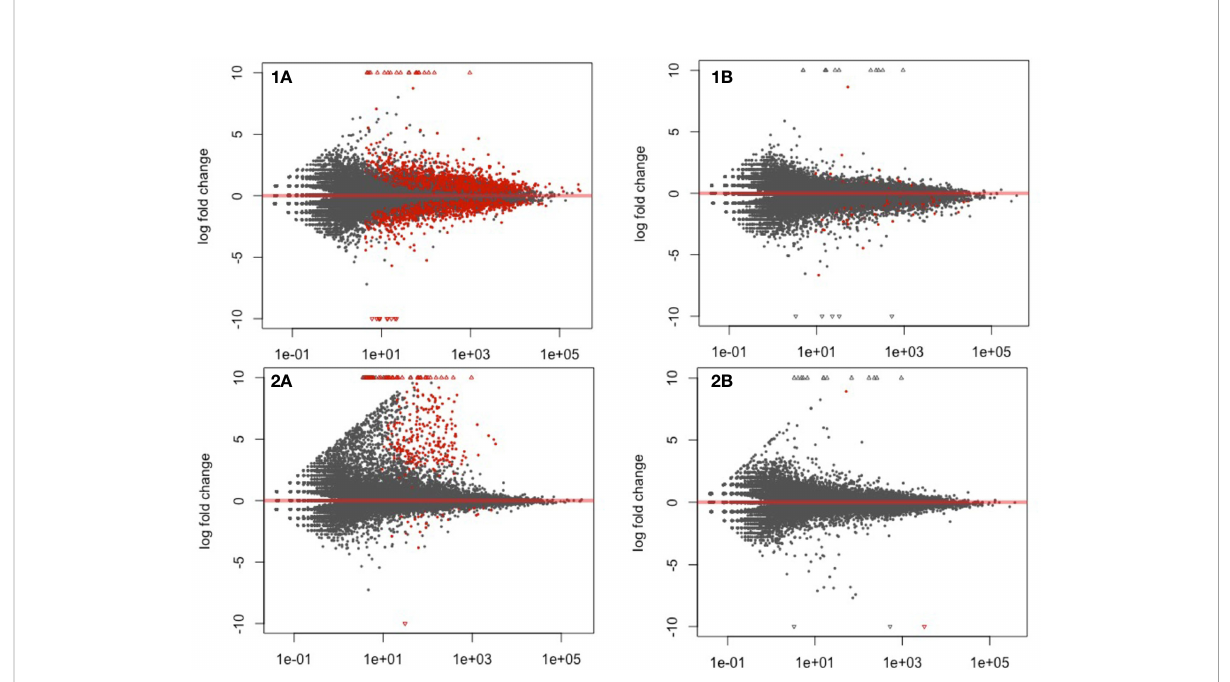
FIGURE 2 Volcano plot highlighting differentially expressed genes in soybean seedlings treated with fl uopyram and pydi fl umetofen, 5 and 10 days after planting (DAP). 1A : Fluopyram 5 DAP; 1B : Fluopyram 10 DAP; 2A : Pydi fl umetofen 5 DAP; 2B : Pydi fl umetofen 10 DAP. Red dots represent differentially expressed genes (DEGs) (Padj<0.05).